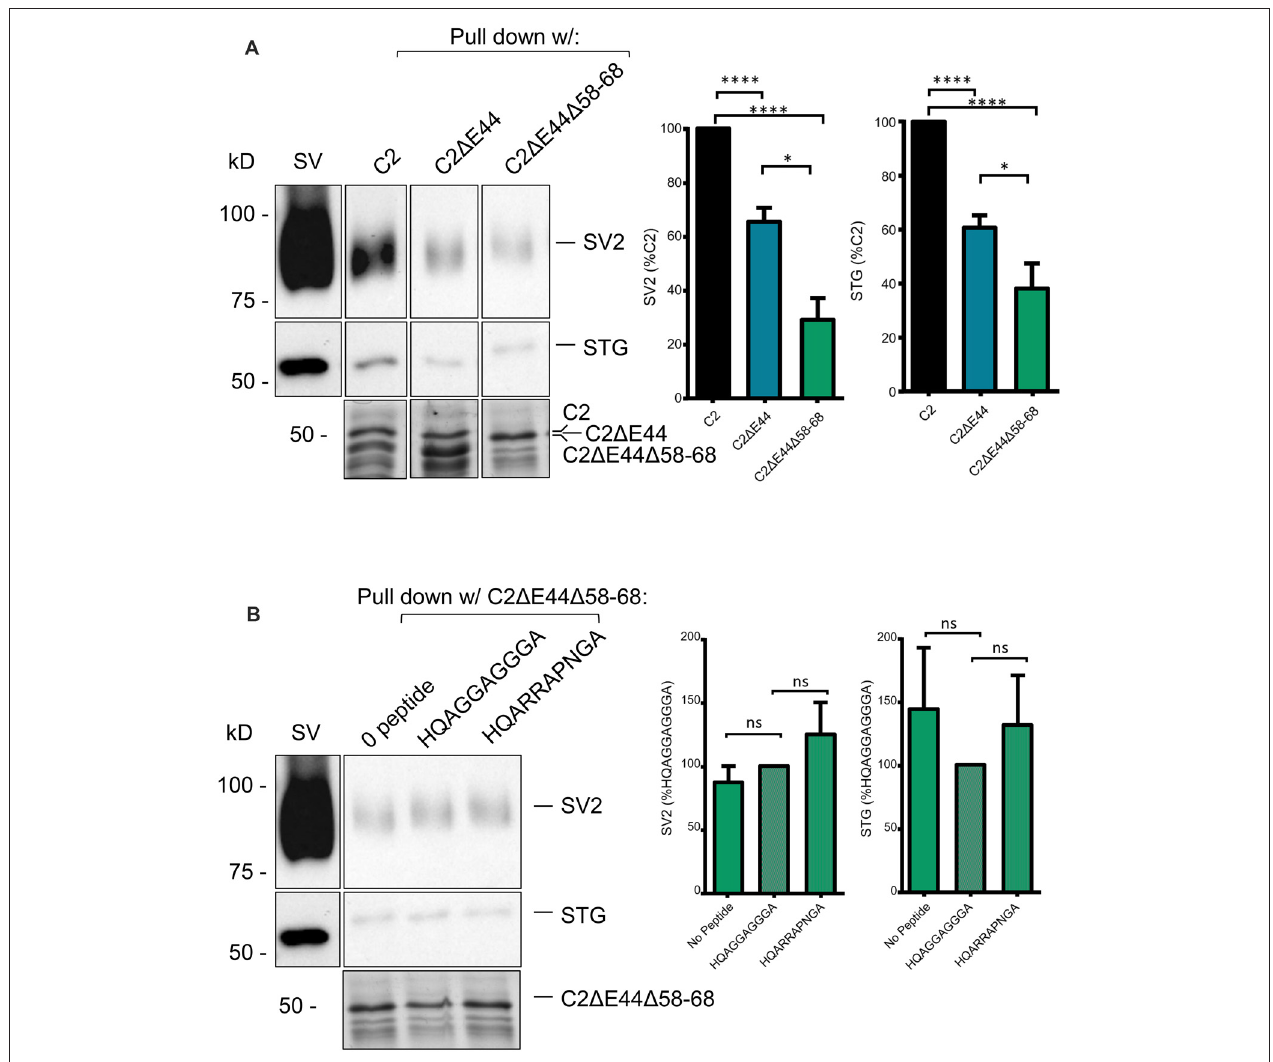
FIGURE 6 | SV-PD with the double C2 ∆ E44 ∆ 58–68 mutant C2 fusion protein. (A) . Left panel : SV-PD with the double-deletion C22 ∆ E44, ∆ 58–68 fusion protein. Right panel : histograms comparing SV2 or STG protein band intensity for the two fusion proteins. ∗ p < 0.05, ∗∗∗∗ p < 0.0001. (B) Lack of effect of the blocking peptide on SV-PD with the double-deletion C22 ∆ E44 ∆ 58–68 fusion protein. Right panel : histogram comparing SV protein band intensity for no peptide, control peptide and blocking peptide conditions. ns p >